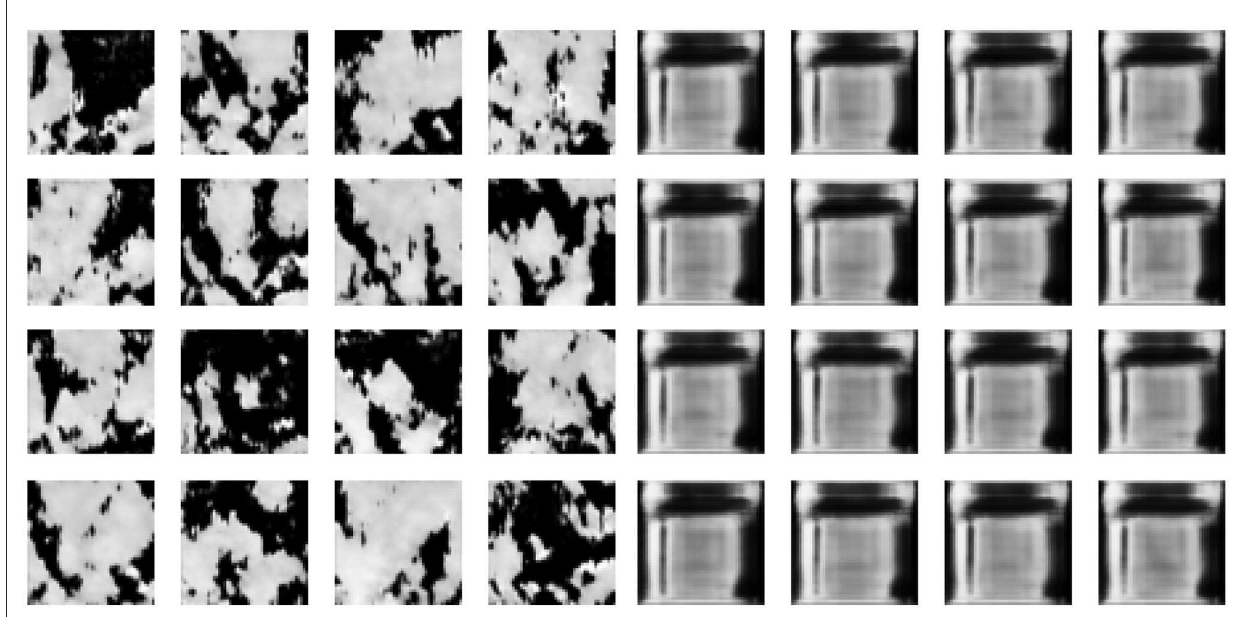
FIGURE4 Images generated on cloud data set for training over 2,000 epochs with a learning rate of 5 × 10 − 5 using (left) TensorFlow (2020b) and (right) Radford et al. (2016) demonstrating a collapse of the model by generating identical images.